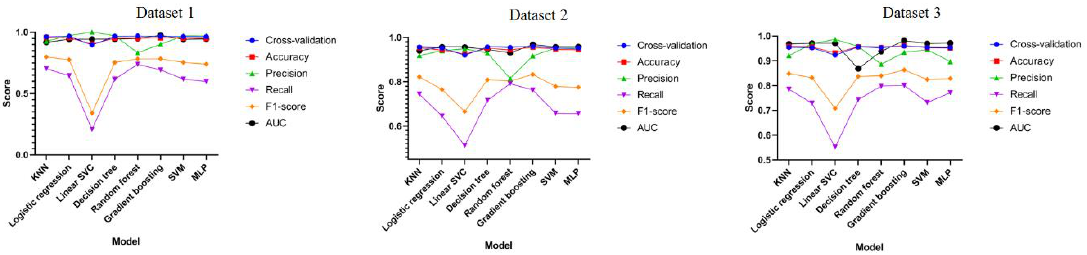
Figure 5. Performance evaluation results according to Datasets 1 to 3 with the elapsed time.